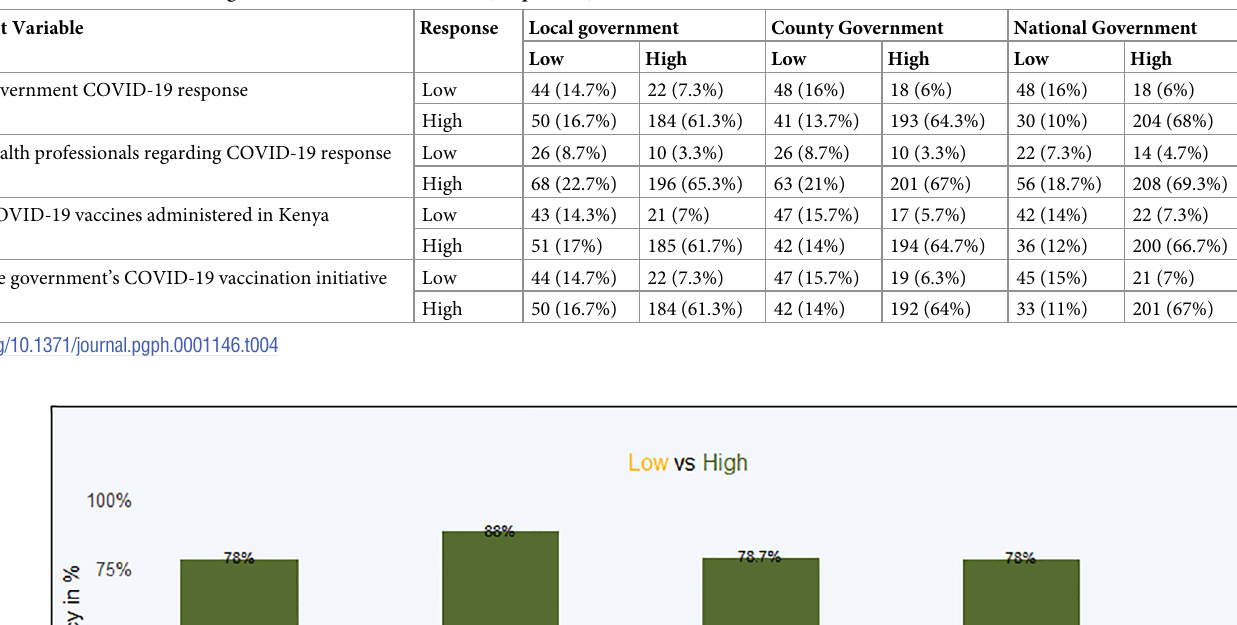
Table 4. COVID-19-related trust among self-confirmed CHVs n = 300 (frequencies).